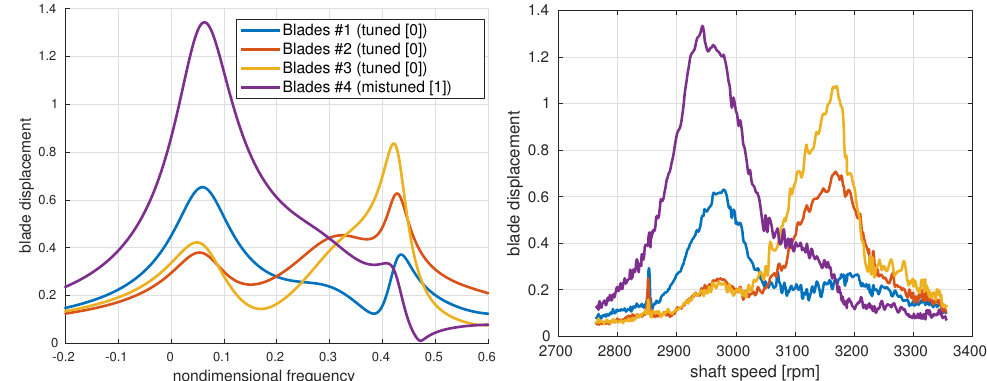
Figure 12. ROM results ( left ) and experimental results ( right ) for the mistuning pattern